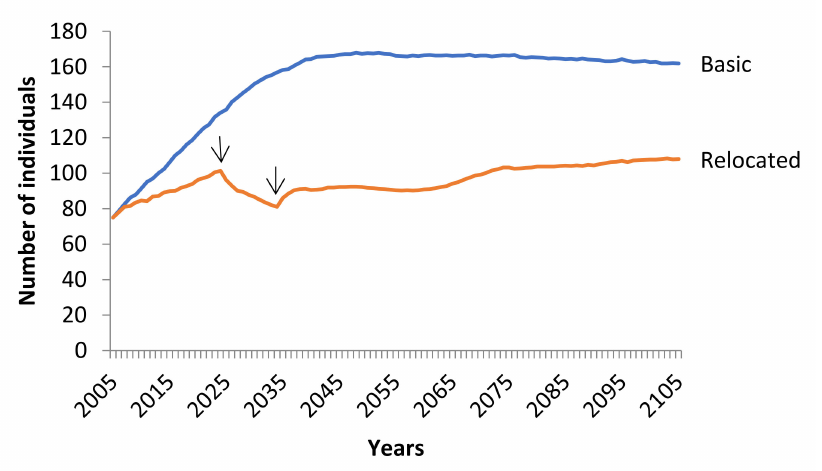
Figure 7. Trend of the population of the Eurasian Black Vulture ( Aegypius monachus ) under the scenario of removing individuals from the Dadia-Lefkimi-Soufli Forest National Park population in order to reintroduce them in the Olympus National Park. Eight juveniles per year removed for consecutive 10 years, i.e., a total of 80 individuals removed from the population of Dadia-Lefkimi- Soufli Forest National Park. The removal was planned to occur during the years 2025–2034 indicated by the arrows. All other parameters remained stable as in the basic